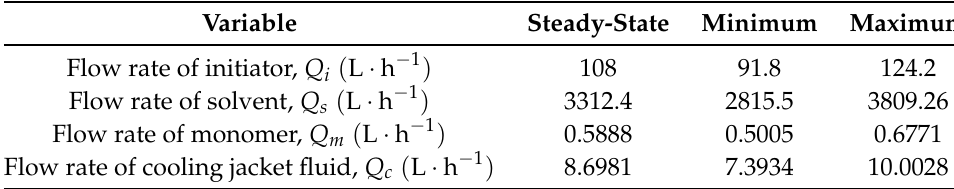
Table 3. Steady-state input conditions and LHS region.